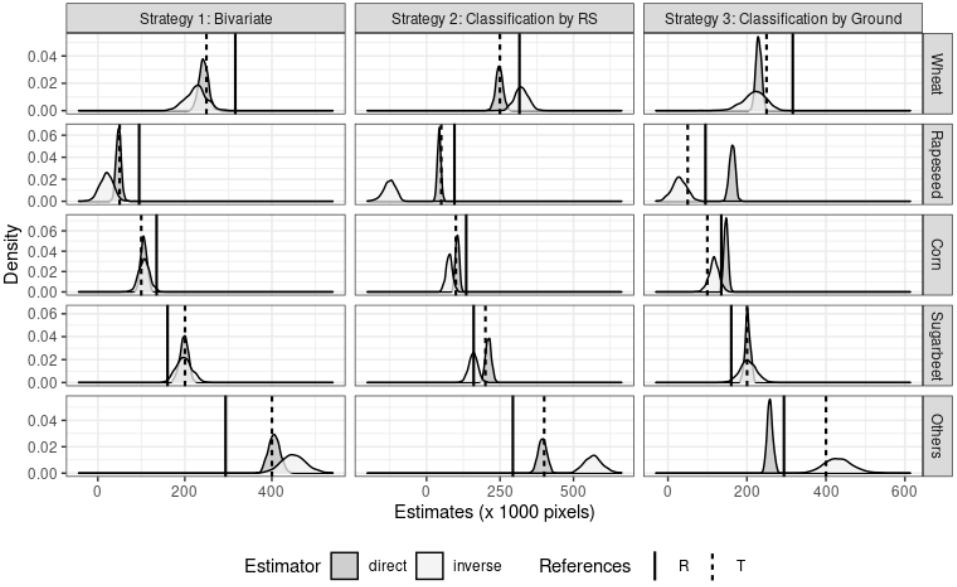
Figure 1. Summary of bootstrap estimates per crop using a thousand replicates.